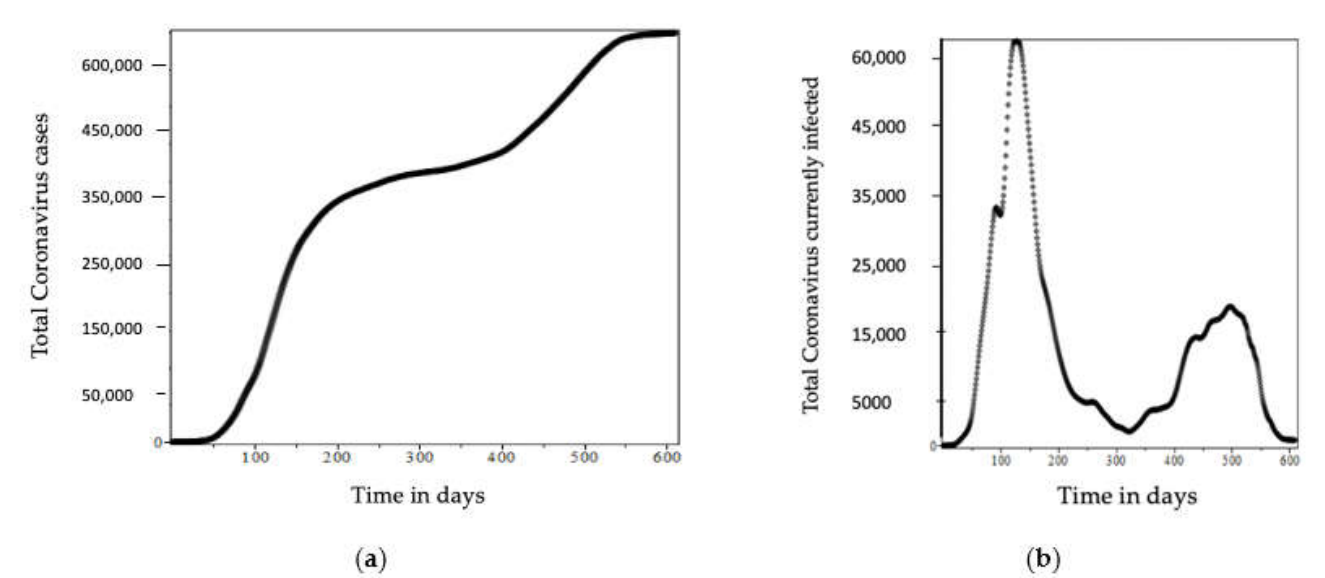
Figure 2. ( a ) Total COVID-19 cases in Saudi Arabia. ( b ) Current active cases in Saudi Arabia (https://www.worldometers.info/coronavirus/country/saudi-arabia/ accessed on 18 December 2021).